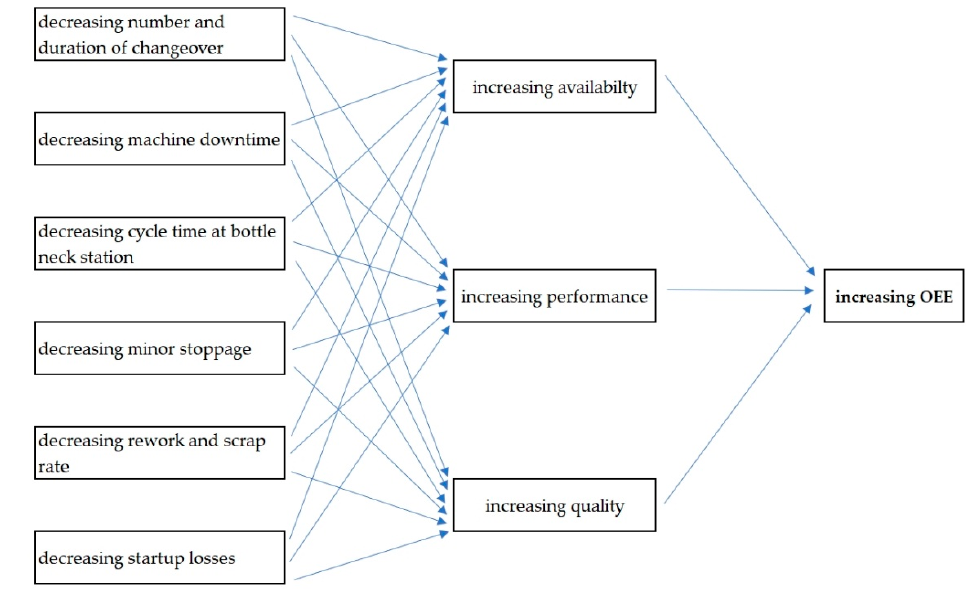
Figure 1. Approach of six big losses and its affects.